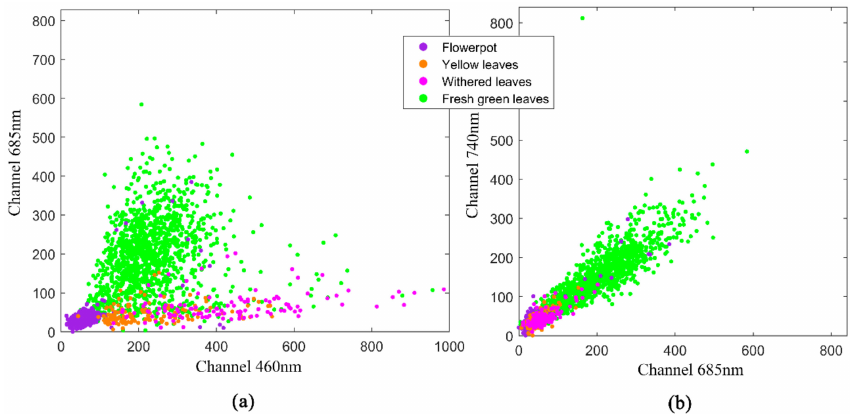
Figure 8. Scatter distribution of the channels’ intensity of the ground categories in scanning experiment of Scene 2: ( a ) Channels 460 nm vs. 685 nm; ( b ) Channels 685 nm vs. 740 nm.